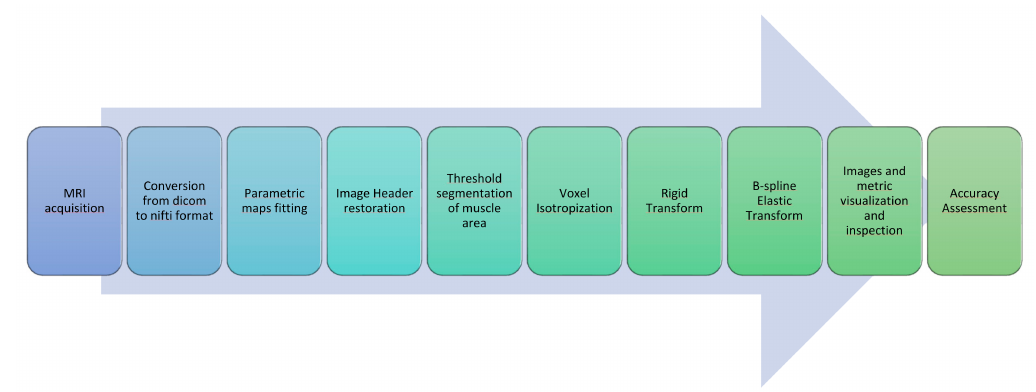
Figure 1. Image processing and registration